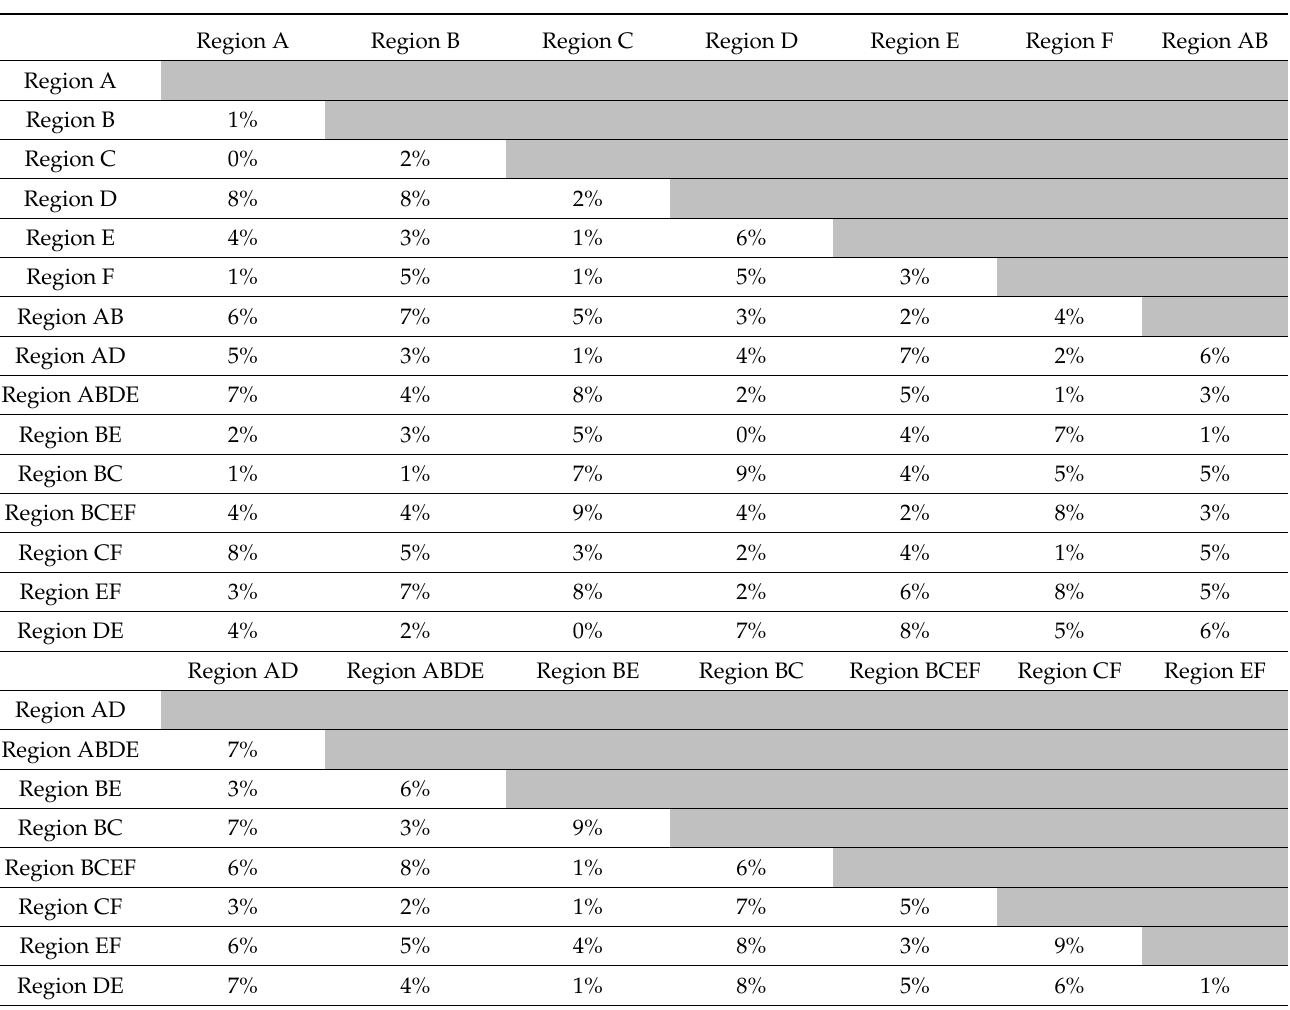
Table 2. Distance from HD inter optimum value between i and j border regions or clock regions of